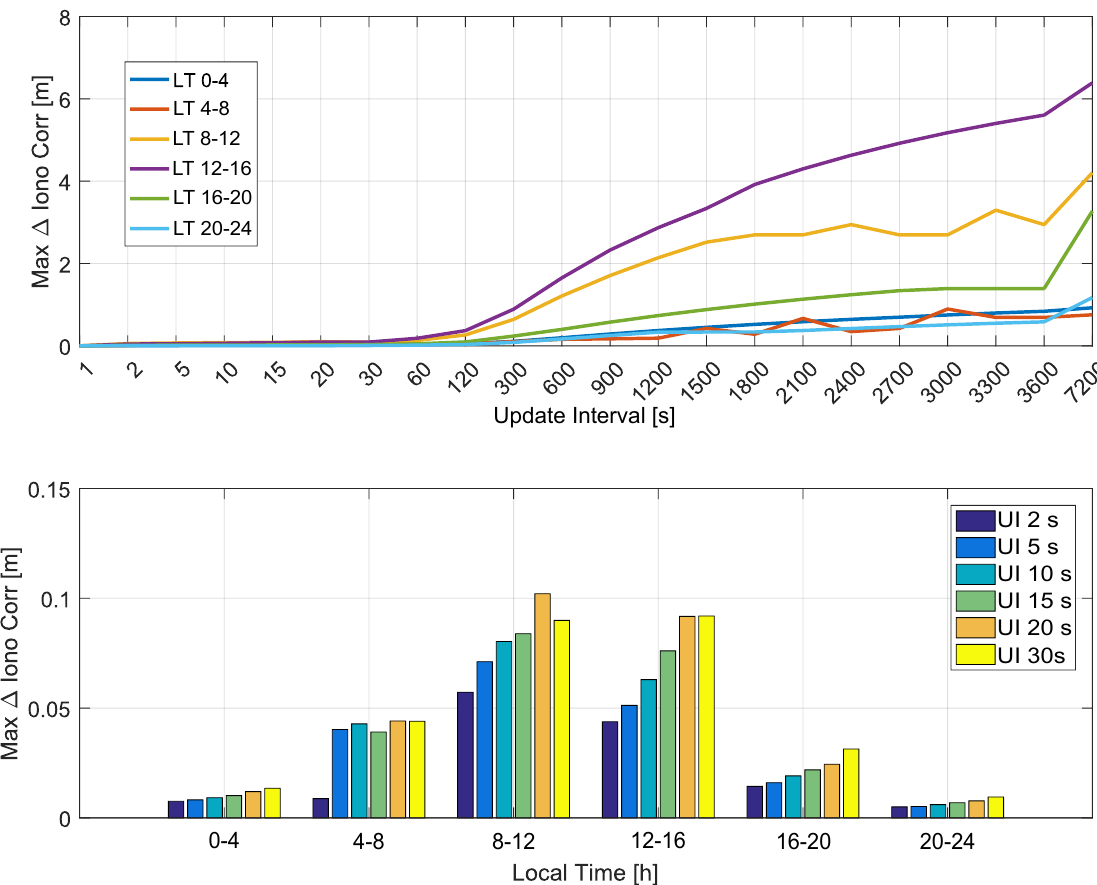
Figure 7. Maximum absolute ionospheric correction differences as a function of the local time. In the legend, “UI” stands for “Update